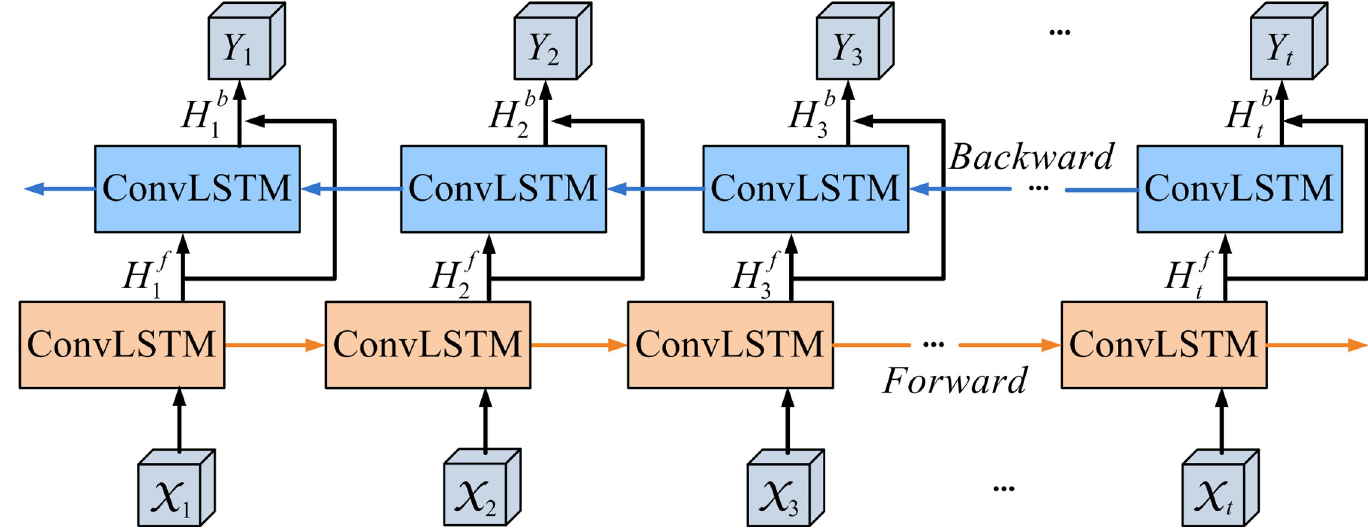
Fig 4. Structure of DB-ConvLSTM